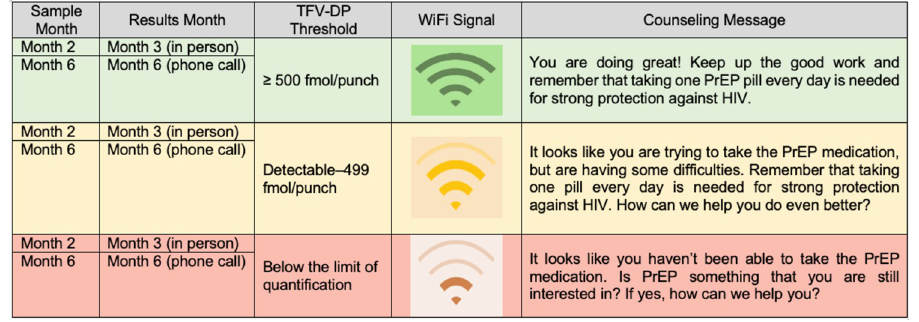
Fig 3. Drug-level feedback counseling messages and corresponding TFV-DP thresholds. “Sample month” refers to the month when the TFV-DP sample was collected. “Results month” refers to the month when the results were given to the participant (e.g., for blood samples drawn at the Month 2 visit, TFV-DP results were reported to participants during their Month 3 visit. For TFV-DP levels greater than or equal to 500 fmol/punch, participants were shown the green wifi signal as a visual representation of their drug levels and they were told the accompanying counseling message by the counselor. For TFV-DP levels between detectable ( > 16 fmol/punch) and 499 fmol/punch, participants were shown the yellow wifi signal and were told the accompanying counseling message. Finally, for TFV-DP levels below the limit of quantification, participants were shown the red wifi signal and were told the accompanying counseling